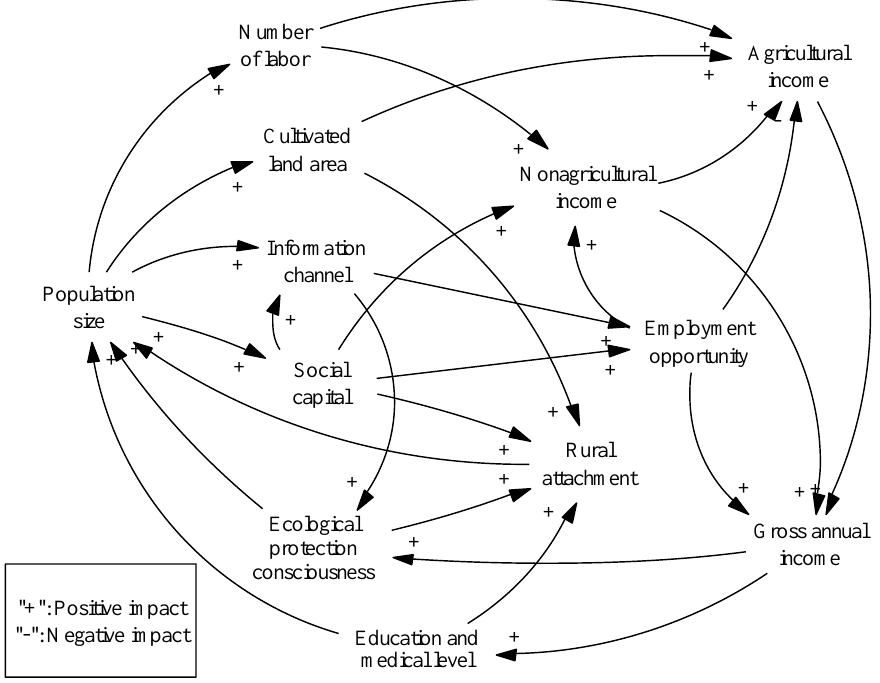
Figure 3. Causality diagram of the coupling system.